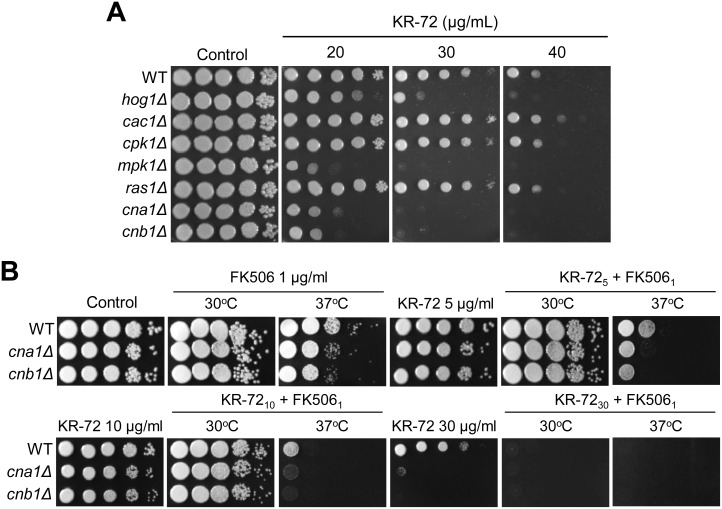

C. neoformans mutants defective in cell wall and membrane integrity exhibited increased susceptibility to KR-72.(a) Each C. neoformans strain [WT (H99), hog1Δ (YSB64), cac1Δ (YSB42), cpk1Δ (YSB127), mpk1Δ (KK3), ras1Δ (YSB53), cna1Δ (KK1), and cnb1Δ (KK2)] was grown overnight at 30°C in liquid YPD medium, 10-fold serially diluted (1 to 104 dilutions), and spotted (3 µL) onto YPD agar containing the indicated concentrations of KR-72. Cells were incubated at 30°C for 3 days and then photographed. (b) The WT H99 strain and cna1Δ (KK1) and cnb1Δ (KK2) mutants were cultured in YPD medium at 30°C for 16–20 h, 10-fold serially diluted (1 to 104 dilutions), and spotted (3 µL) onto YPD agar containing the indicated concentrations of KR-72 (5 [KR-725], 10 [KR-7210], or 30 µg/mL [KR-7230]), FK506 (1 µg/mL, FK5061), or a combination of both (KR-725+FK5061, KR-7210+FK5061, or KR-7230+FK5061). Cells were then incubated at 30°C or 37°C for 3 days and then photographed.